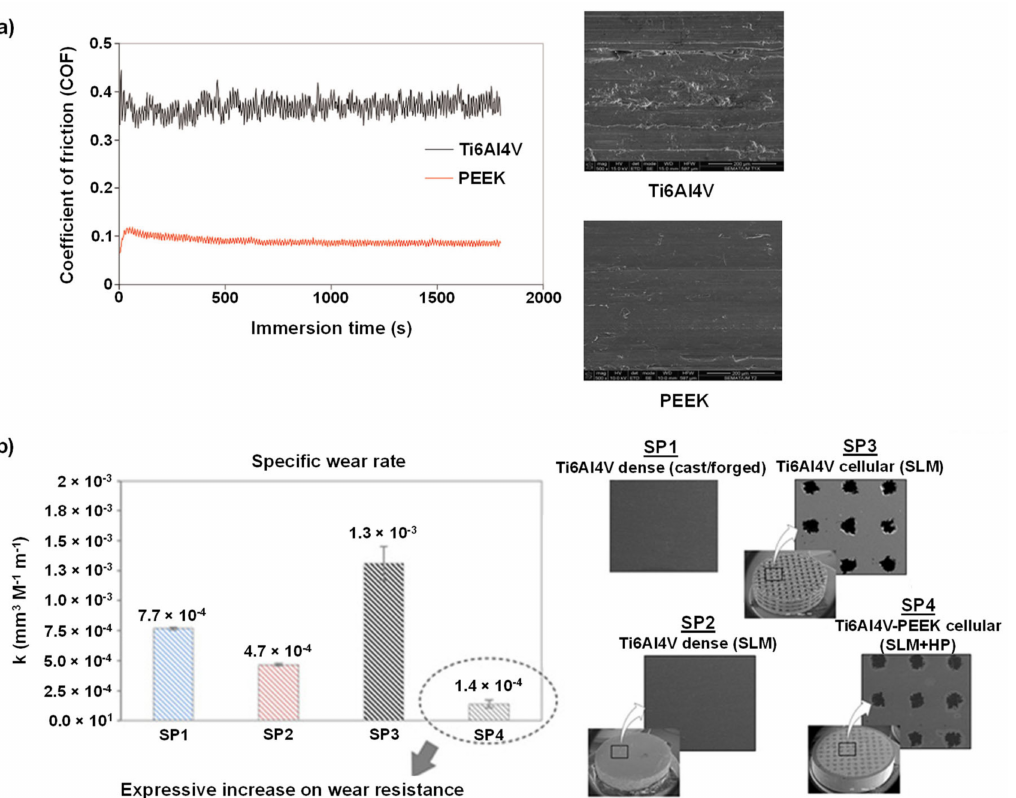
Figure 5. ( a ) Coefficient of friction as a function of immersion time of Ti6Al4V and PEEK (left) and the corresponding FEG-SEM images of the worn surfaces after reciprocating sliding tests against Al 2 O 3 immersed in artificial saliva at 37 ◦ C (right) [87]. ( b ) The specific wear rate of various Ti6Al4V-PEEK multi-material specimens against alumina normal load of 6 N at a frequency of 1 Hz and 3 mm of stroke length in Phosphate Buffer Solution at 37 ◦ C (left) and the corresponding SEM images (right). SLM = selective laser melting, HP = hot pressing [96]. The figures were adopted and modified from literature